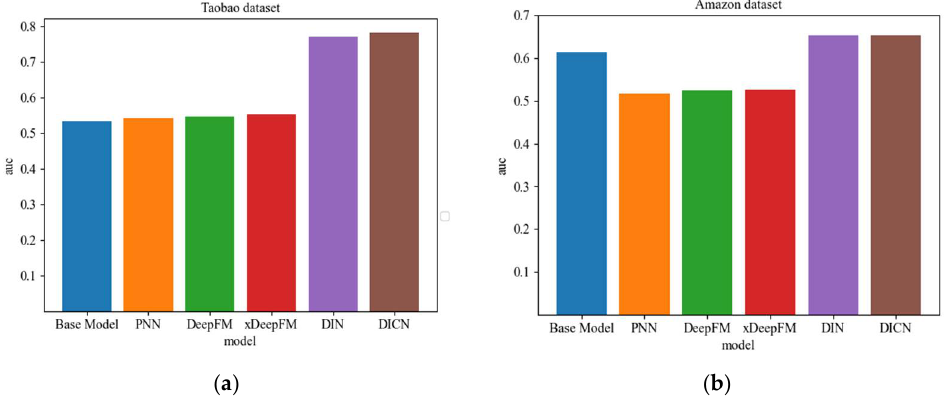
Figure 3. Comparison of AUC of each model under two datasets. ( a ) AUC of the Taobao dataset in the test set of the six models. ( b ) AUC of the Amazon dataset in the test set of the six models.